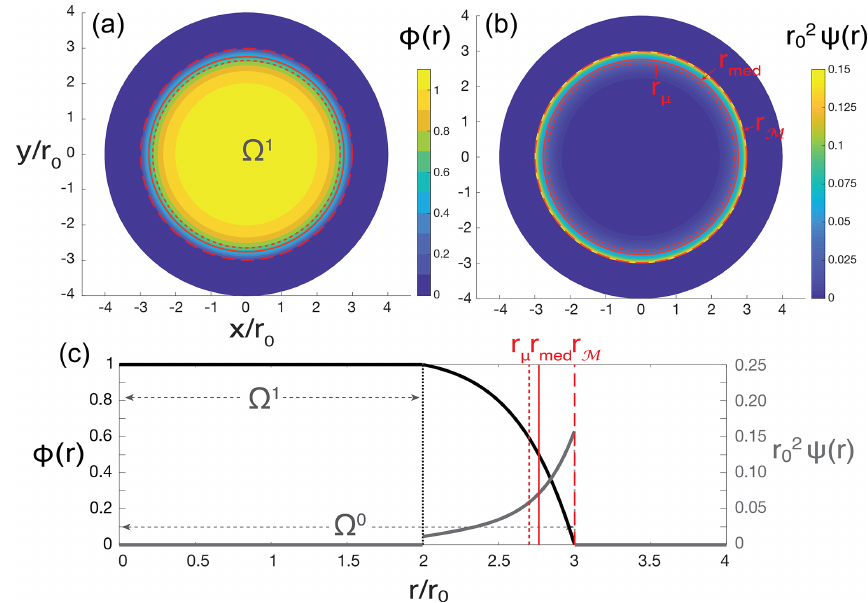
Figure 2. (a) PHM and (b) PHDM examples for the freezing viscous gravity current model under a uniform sampling of the freezing rate parameter (cid:48) . (c) One-dimensional profile of the PHM and PHDM with the distribution centers indicated. This example was calculated with r N ((cid:48) min )/r 0 = 2 and r N ((cid:48) max )/r 0 = 3 or (cid:48) min /τ = 255 and (cid:48) max /τ = 6560.